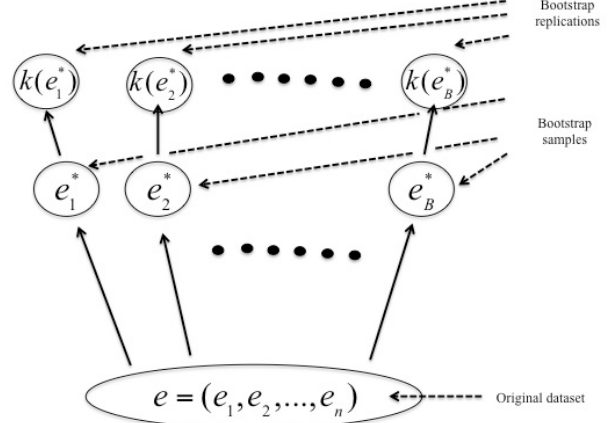
Figure 3: Bootstrap error method schematization